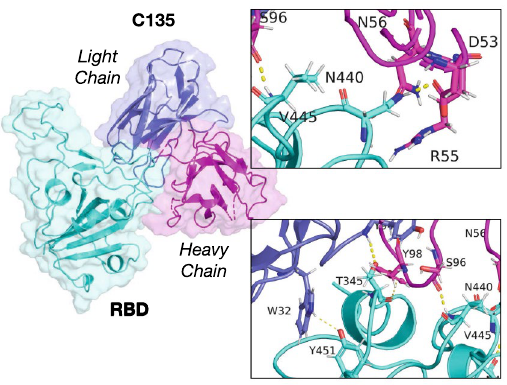
Figure 4. C135 antibodies Fabs link to the S-protein RBD structure. The RBD is shown in cyan while the heavy chain (HC) and light chain (LC) are shown in magenta and blue,